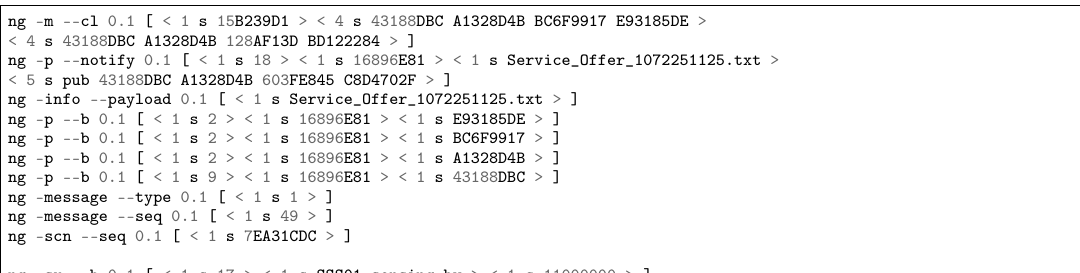
Figure 14. Log of APS service offer to RMS.